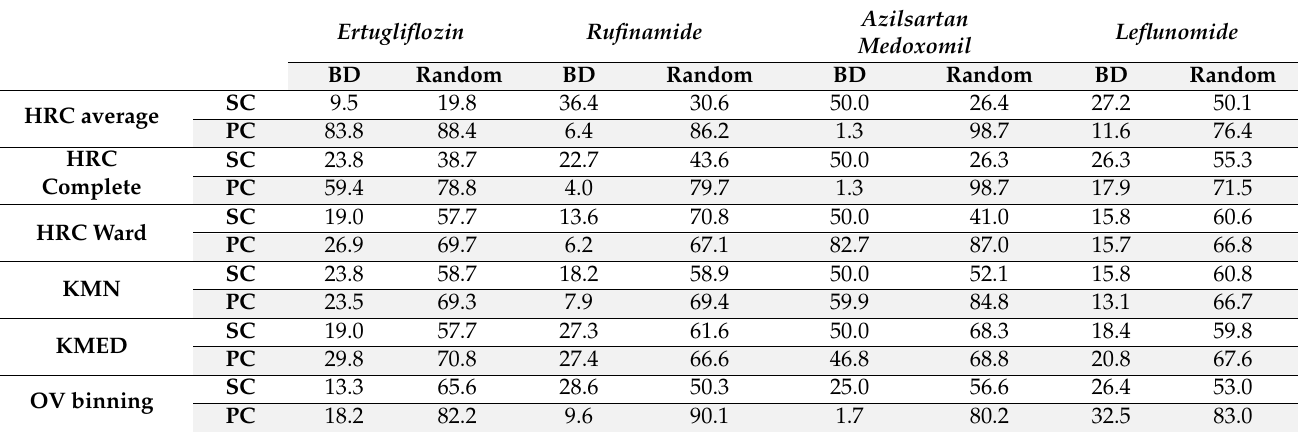
Table 4. Comparison of SC and PC values obtained by random selection and BD compounds when dividing the MCL of each patent in N BD clusters for Ertugliflozin, Rufinamide, Azilsartan Medoxomil and Leflunomide